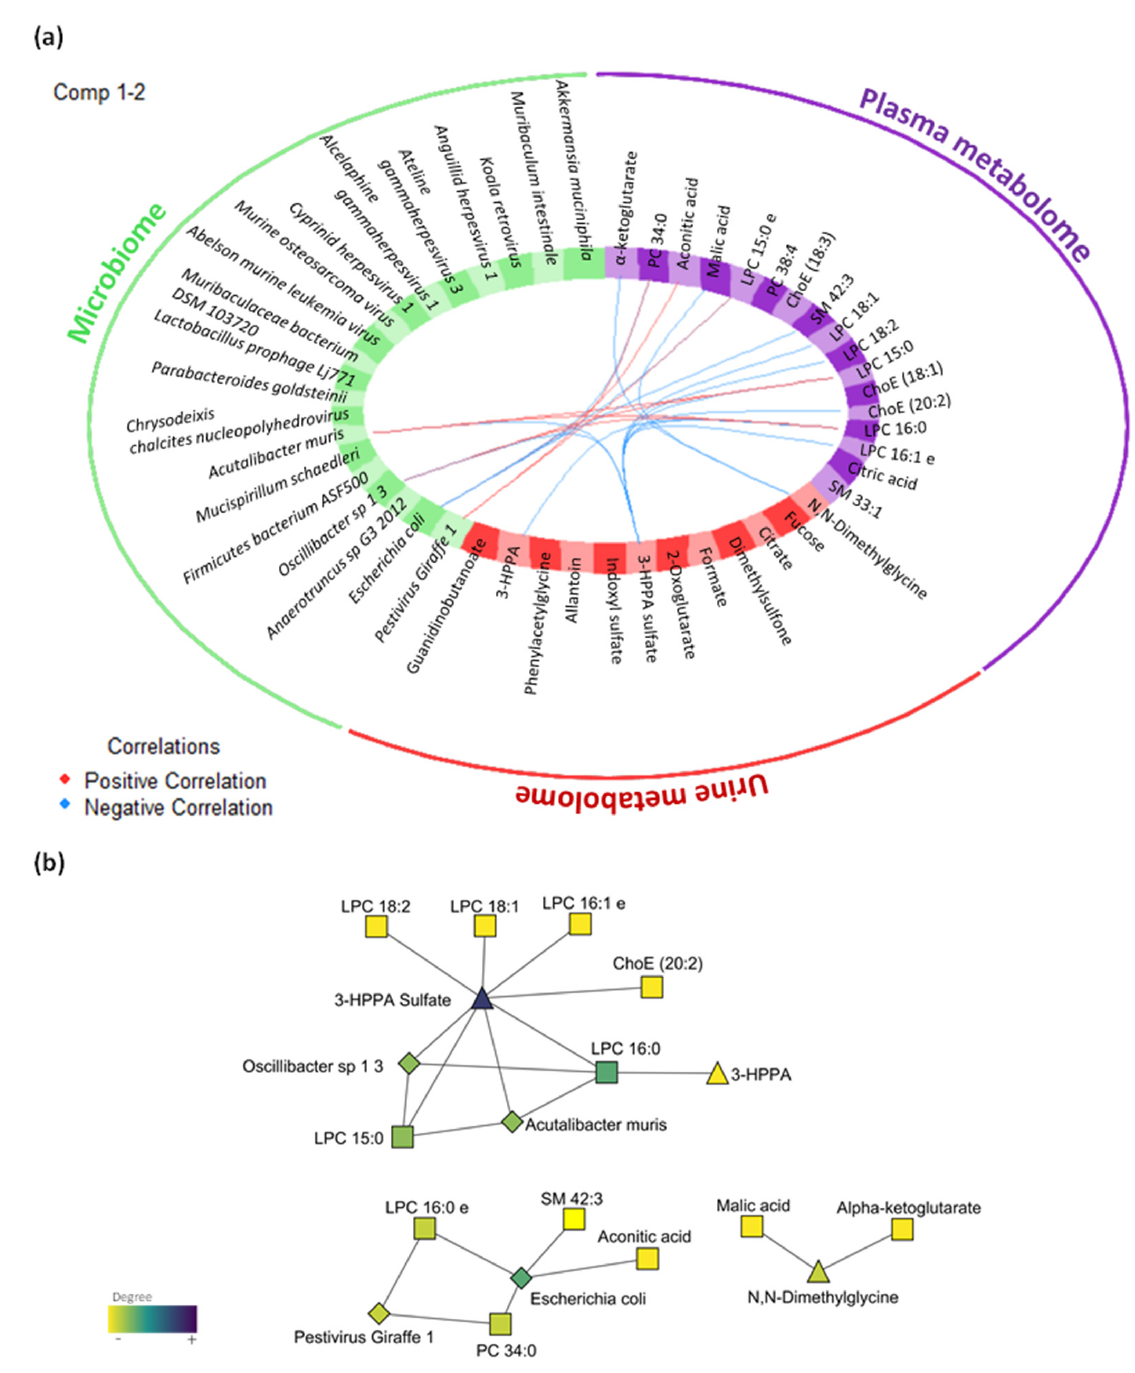
Figure 5. Multi-omics integration of plasma metabolome, urine metabolome and microbiome in the LPS-induced inflammation model. ( a ) Circos plot output from DIABLO. Each quadrant indicates the type of features: plasma metabolites (purple), urine metabolites (red), microbiome (green). ( b ) Further visualization of the network from DIABLO using Cytoscape. The shape of the features indicates the type of feature: plasma metabolites (square), urine metabolites (triangle) and metagenomics (diamond). The colour indicates the degree of each feature in the network (i.e., nodes with more connections). Abbreviations: ChoE, cholesterol ester; TG, triglyceride; PC, phosphatidylcholine; SM, sphingomyelin; LPC,